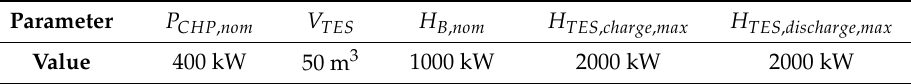
Table 5. Size of the components adopted in the rolling-horizon parametric